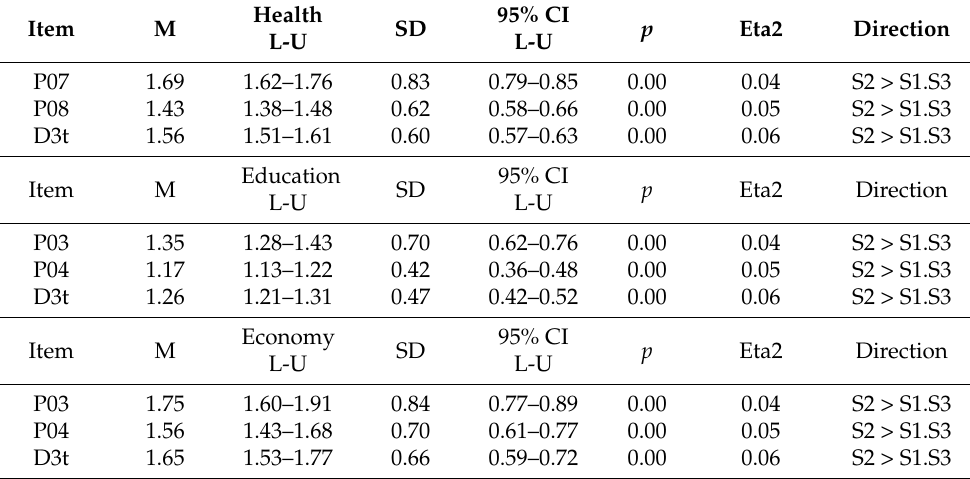
Table 8. ANOVA for independent samples by sector for dimension D3. Health Item M L-U